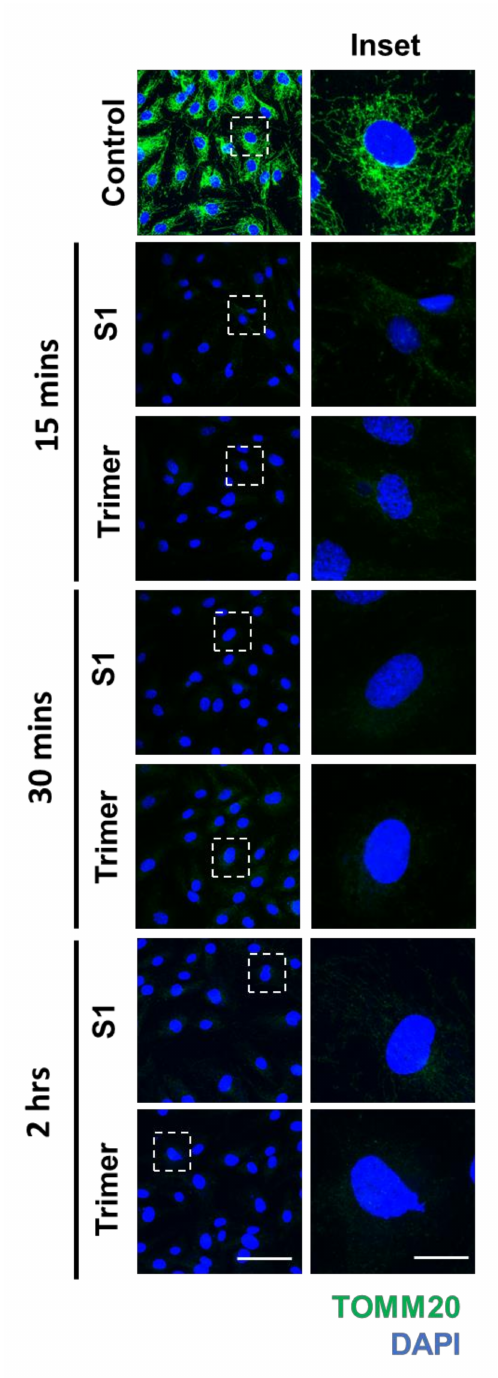
Figure 4. The spike proteins induce a decrease in the mitochondrial protein in the brain ECs. Primary human brain ECs were treated with 15 nM of S1 domain of spike protein (S1) and active trimer (Trimer) for 15, 30 min, and 2 h, respectively. Both are stained with antibody against translocase of the outer mitochondrial membrane complex subunit (TOMM) 20, a marker for the mitochondria (green). DAPI (blue) indicates nucleus. Insets indicate magnified images of squares of dashed lines. Scale bar, 75 µ m (left panel); 20 µ m (right